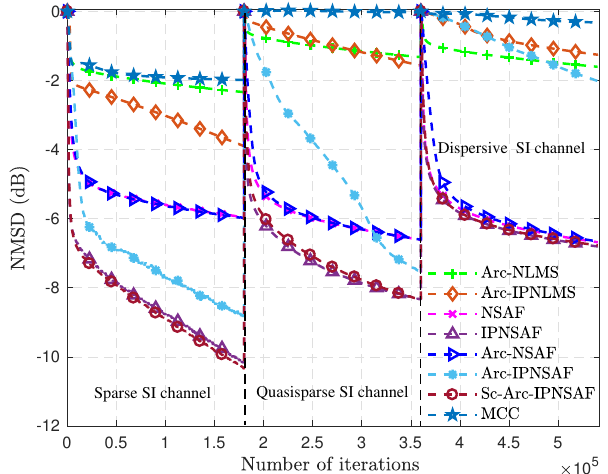
Figure 6. NMSD of different algorithms in sparse, quasisparse, and dispersive SI channels, and the input signal is the BPSK signal.